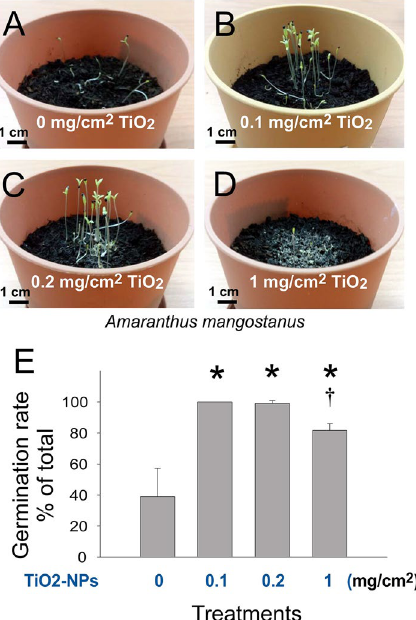
Figure 1. TiO 2 NPs treatments on soil enhanced the germination rate of Amaranthus mangostanus seeds. Images of 1-week-old seedlings of Amaranthus mangostanus after seeding on soil without ( A ) or with ( B–D ) addition of pure TiO 2 NPs are shown. The seed germination rates of aforementioned conditions were quantified ( E ). * P < 0.05 vs. 0 mg/cm 2 TiO 2 untreated groups, † P < 0.05 vs. 0.2 mg/cm 2 TiO 2 groups. n = 3 (3 independent experiments; each experiment with 30 seeds). ( A–D ) Pot diameter: 10 cm; scale bars: 1